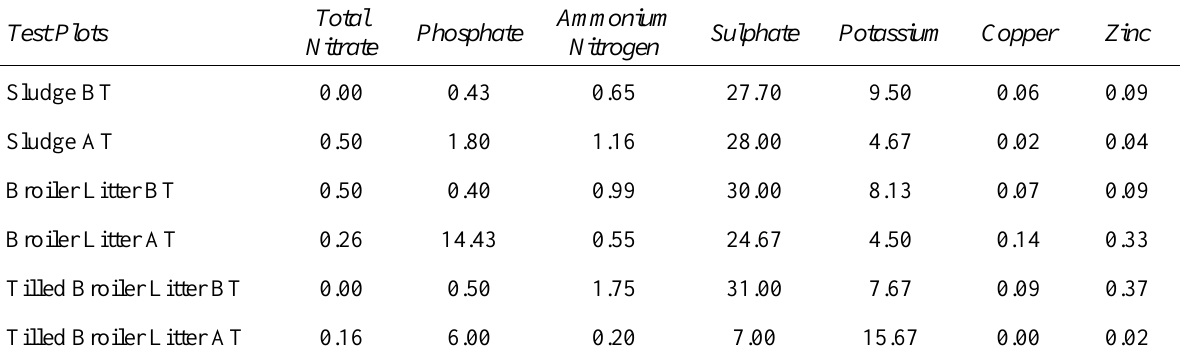
Table 1: Before treatment and After treatment levels (ppm) of total nitrate, phosphate, ammonium nitrogen, sulphate, potassium, copper and zinc in runoff from experimental plots. Test Plots